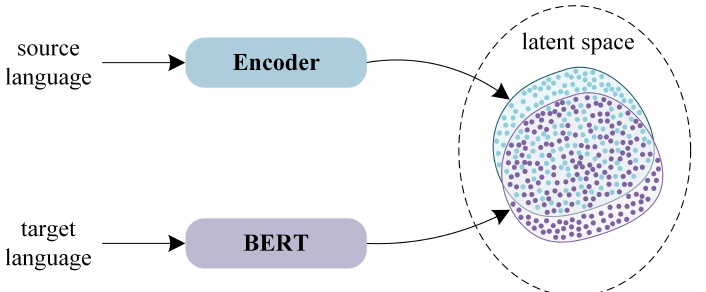
Figure 1. The principle of our approach: aligning the source language and the target language in latent